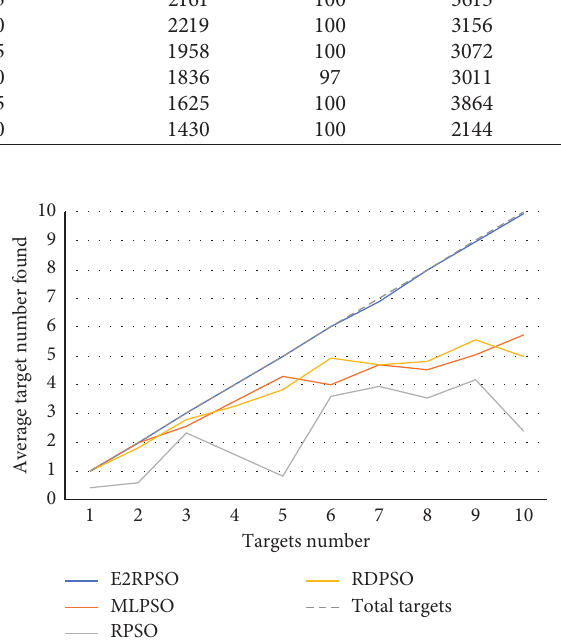
Figure 5: Comparison of average targets found under different targets